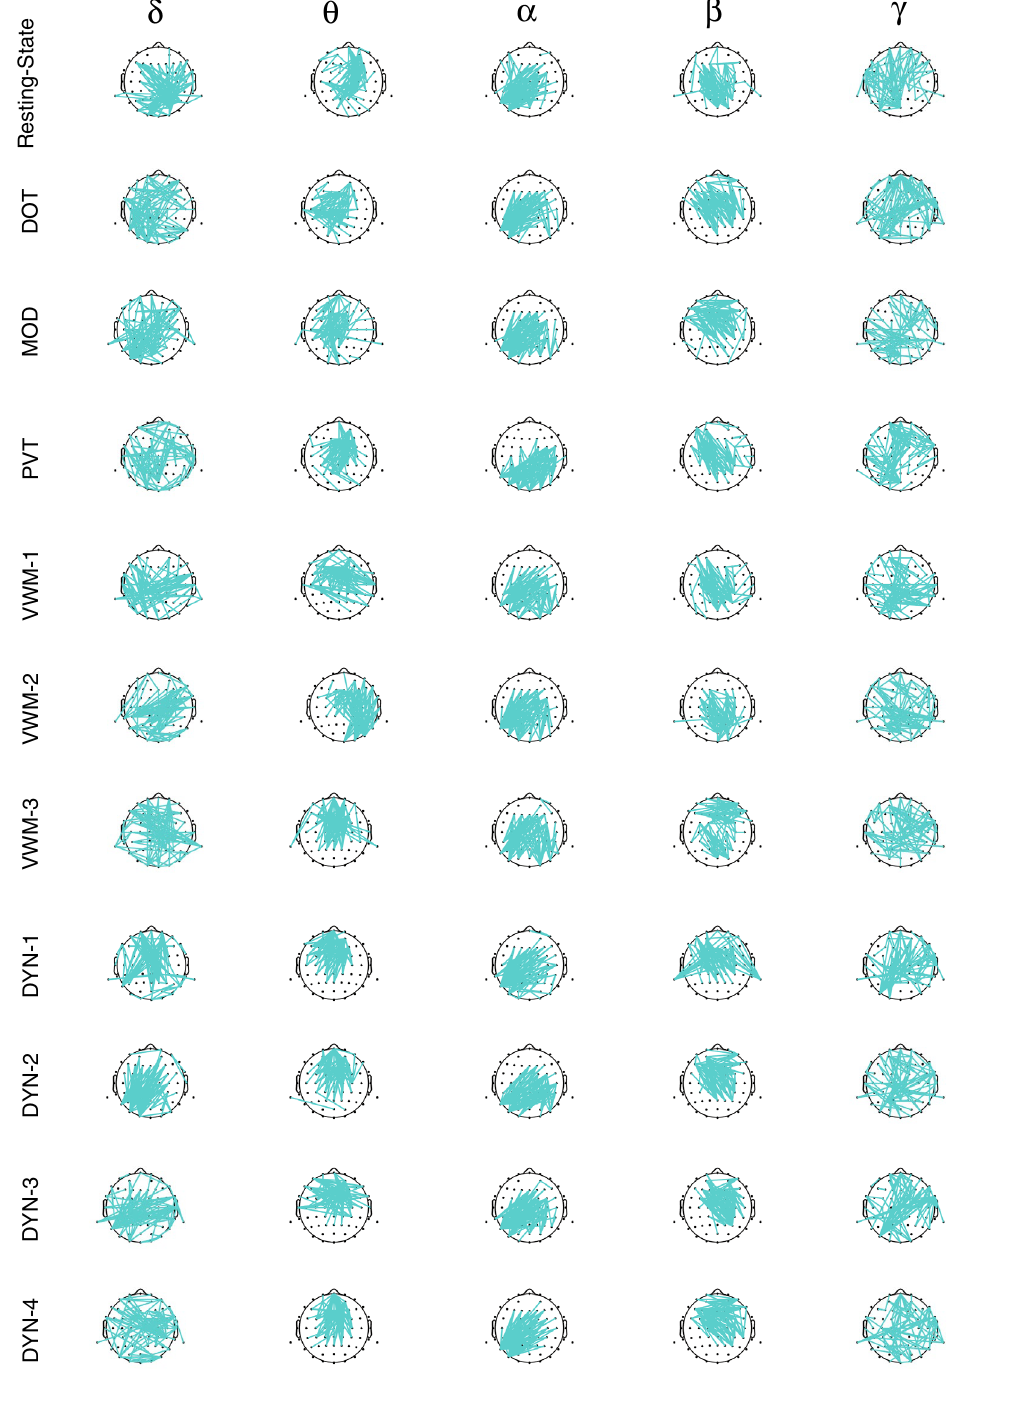
Figure 4. Scalp distribution across tasks for top 5% of ICC w scores. For Resting-State and each task: DOT, PVT, MOD, VWM-1:3, and DYN-1:4, (11 in total), connections with ICC w scores in top 5% for δ, θ, α, β and γ frequency bands are plotted on the scalp. DOT dot probe task, DYN dynamic attention task, MOD modular math task, PVT psychomotor vigilance task, VWM 1–3 visual working